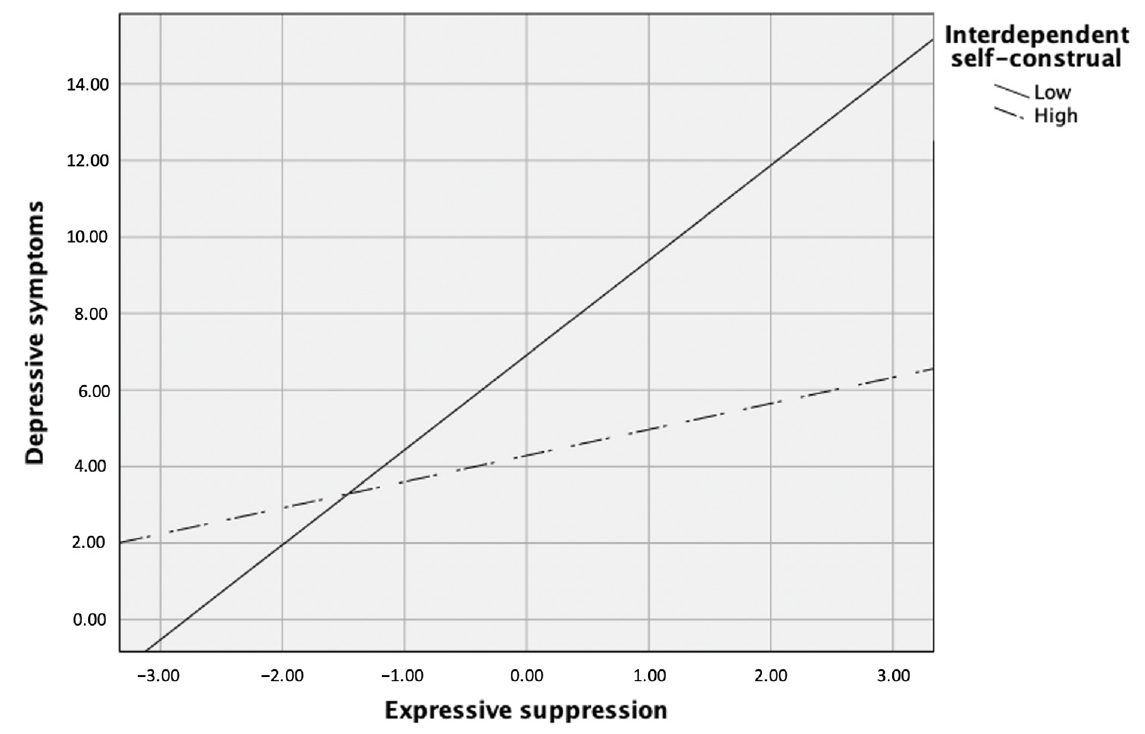
Figure 5. Interdependent self-construal as a moderator between expressive suppression and depressive symptoms. Drawing from the above findings, bootstrapping was conducted to examine the medi- ation effects. Based on 5000 bootstrap samples with replacement, the 95% CI indicated that the standardized indirect effects of mindfulness on life satisfaction (CI: ( − 0.10, 0.05))